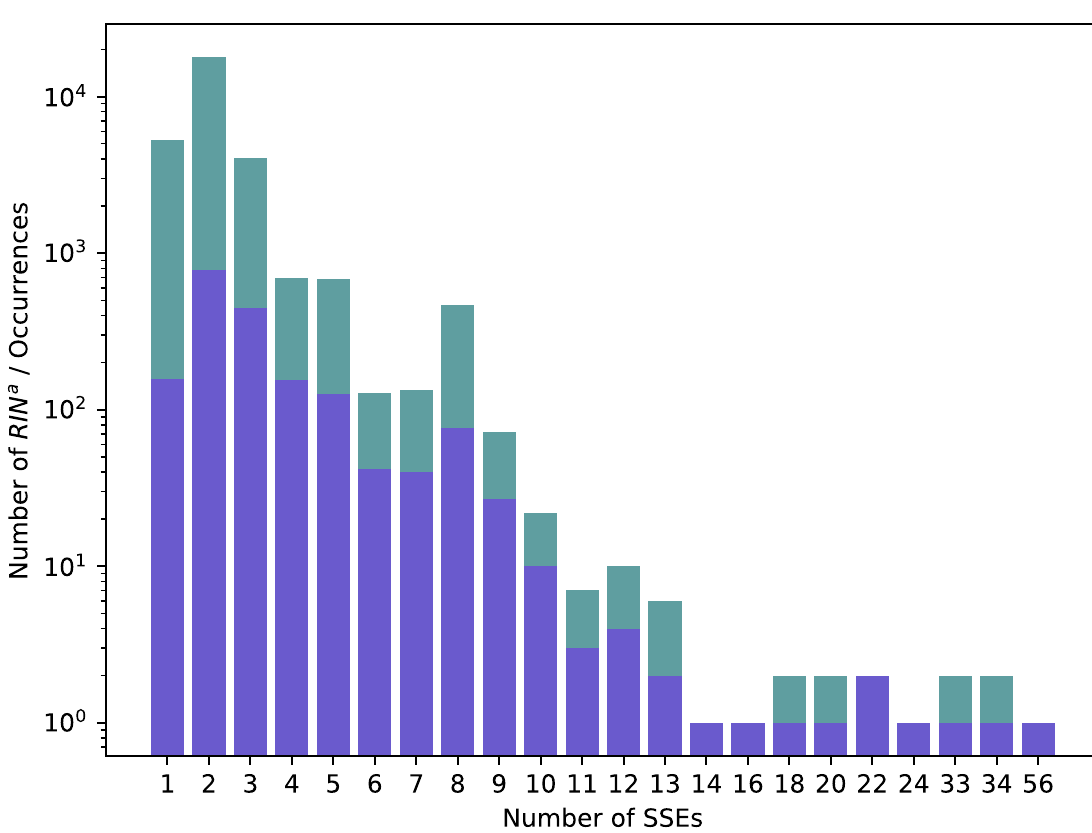
(in blue) and all their occurrences (in green) over the different s